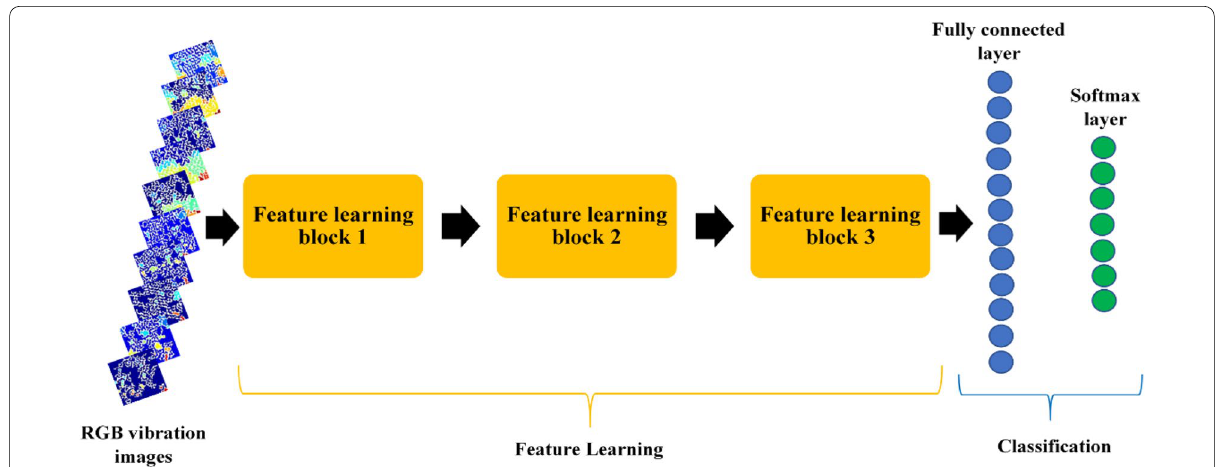
Figure 5 Structure of the CNN used in this study